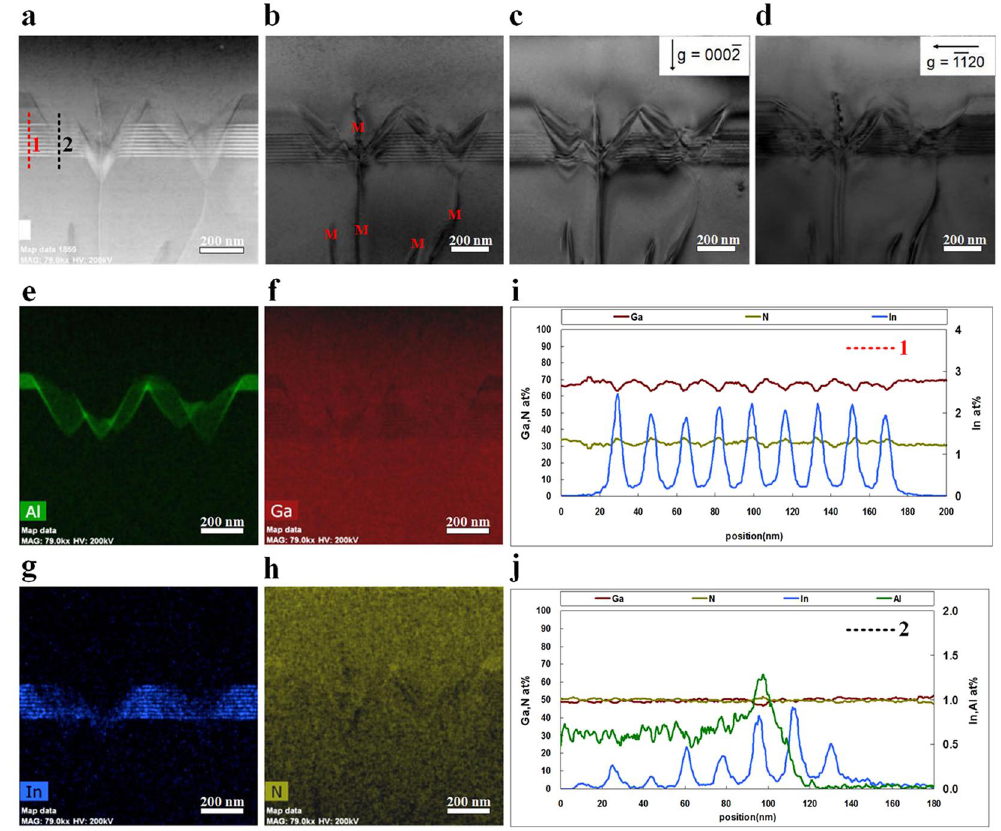
Figure 7. ( a ) Cross-sectional HAADF-STEM image of V-pit-embedded green InGaN/GaN MQW grown on 6 SL periods. The HAADF-STEM image clearly shows the atomic number contrast between In 0.25 Ga 0.75 N well layers (bright contrast) and GaN barrier layers (dark contrast). The V-pits nucleate at TDs. ( b ) Cross-sectional bright-field TEM image showing mixed dislocations running through the apex of the V-pits. Bright-field TEM images of the MQW sample taken at the same area under two-beam diffraction conditions with ( c ) g = (0002) and ( d ) g = (11–20). EDX elemental mapping images showing ( e ) Al, ( f ) Ga, ( g ) In, and ( h ) N maps in green, red, blue, and yellow, respectively. EDX line scans through the MQW sample were obtained in HAADF-STEM mode by performing the scanning vertically along ( i ) surrounding planar MQWs and ( j ) (10–11) sidewall MQWs of the